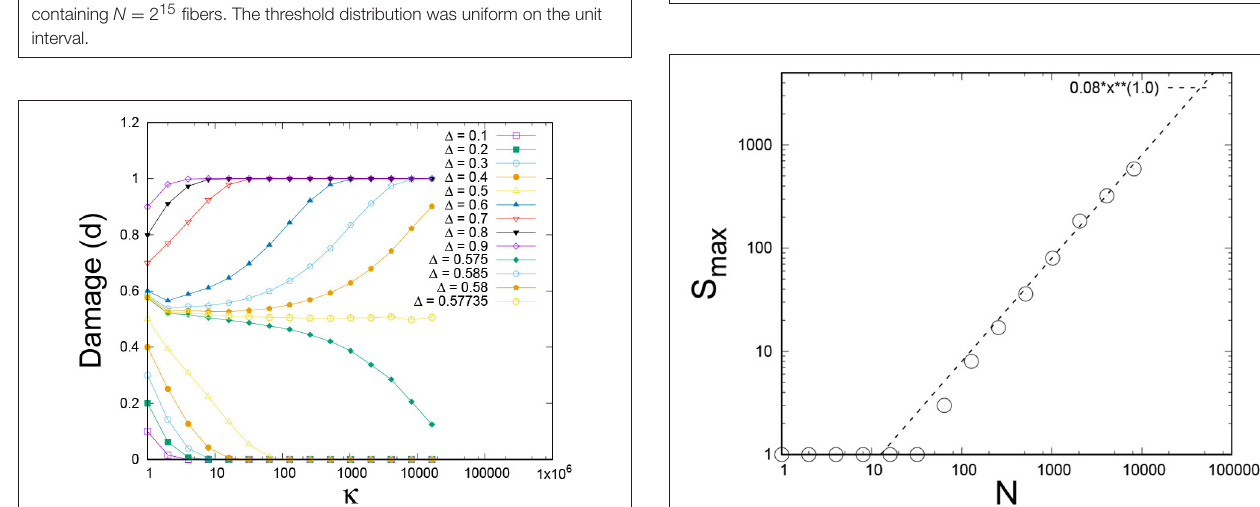
FIGURE 11 | Evolution of the histogram of avalanche sizes as the real space renormalization group is iterated. The initial threshold distribution was uniform on the unit interval. The initial number of fibers was N were taken over 10 5 samples.